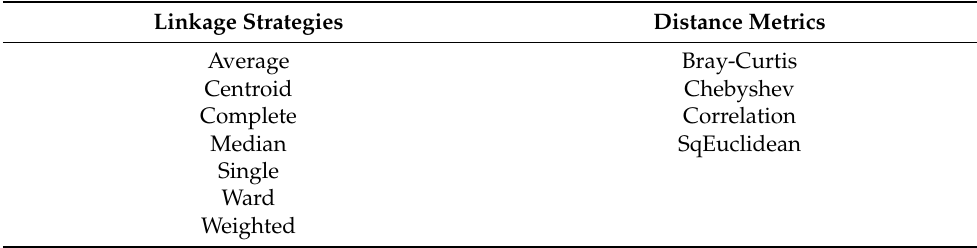
Table 1. Parameters for the hierarchical clustering